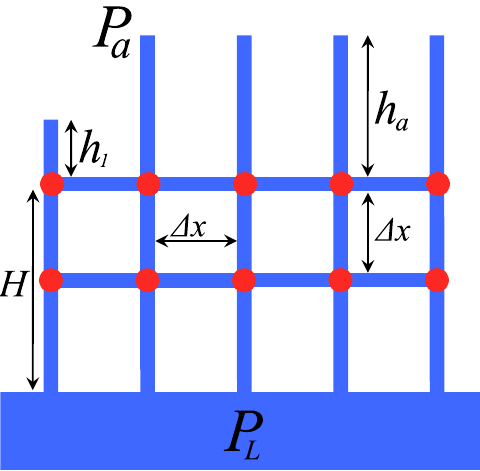
Figure 12. Simplified network model of a porous medium with two horizontal capillary layers. The parts of the channels filled with liquid are marked with a thick